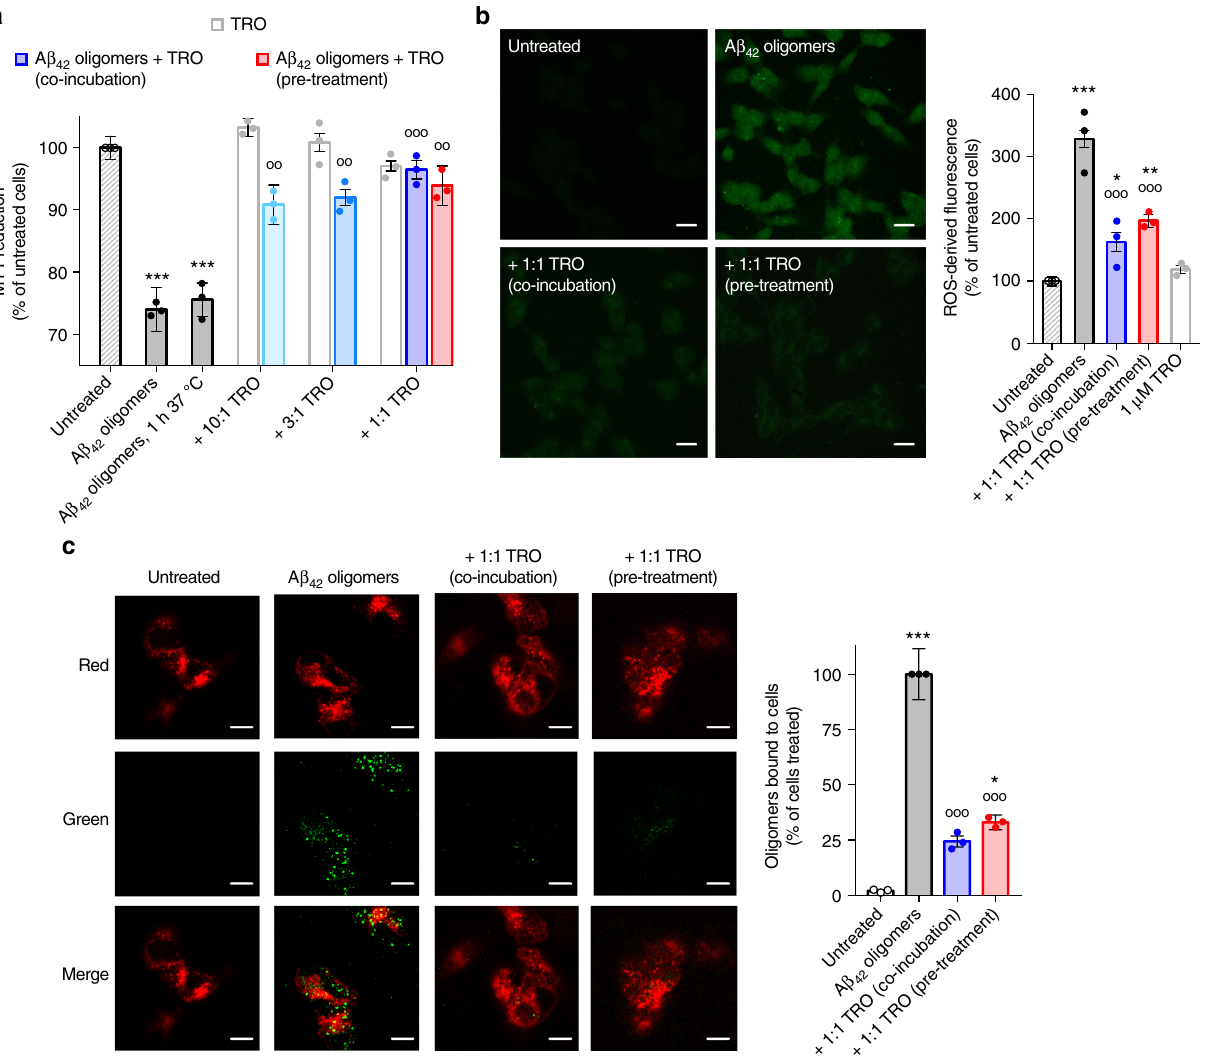
Fig. 3 The toxicity of A β 42 oligomers is reduced by trodusquemine. a Effects of trodusquemine on the A β 42 oligomer-induced decrease of MTT reduction. Oligomers (1 µ M) were incubated in the absence or presence of 10:1 – 1:1 ratios of A β 42 -to-trodusquemine (blue bars) for 1 h at 37 °C and incubated